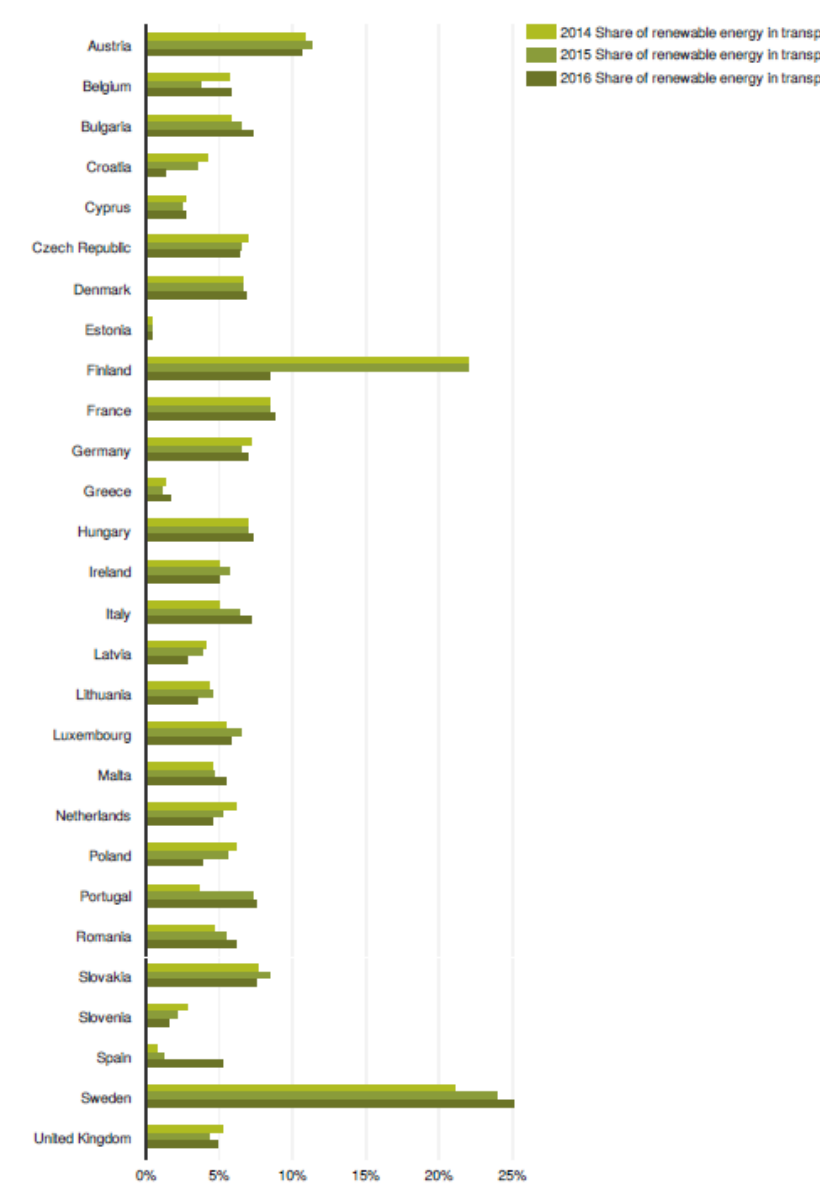
Figure 2. EU share of renewable energy in transport in 2014, 2015 and 2016 [6].